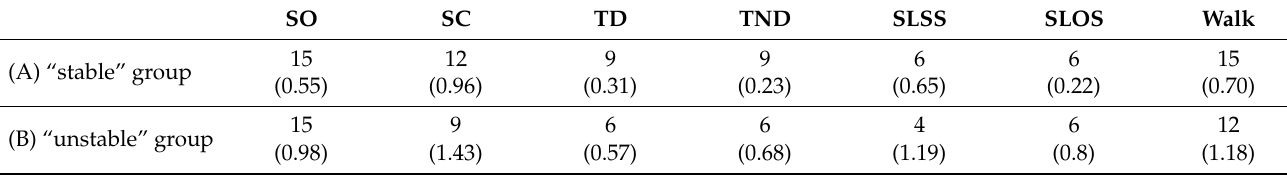
Table 4. Median ± SE for the level of losing postural balance in individuals in the “stable” and the “unstable”